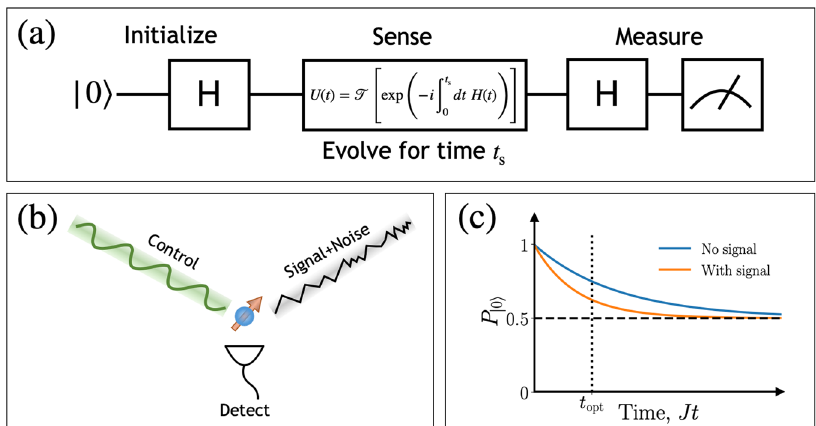
Fig. 1 Schematic description of the single-qubit experiment for detection of a signal. a The detection protocol. The qubit is initialized in an eigenstate of ^ σ x , ψ in j i ¼ 1 ffiffi p ð 0 j i þ 1 j iÞ and evolves in the presence of a signal, background noise, and control. The measurement is done in the 2 ^ σ z basis after a Hadamard rotation. b Schematic picture for the detection setup. c The average probability of the occupation of state 0 j i (denoted by P 0 j i ) decays as a function of time, with the decay rate dependent on the presence/absence of a signal. The detection is optimally performed at t opt